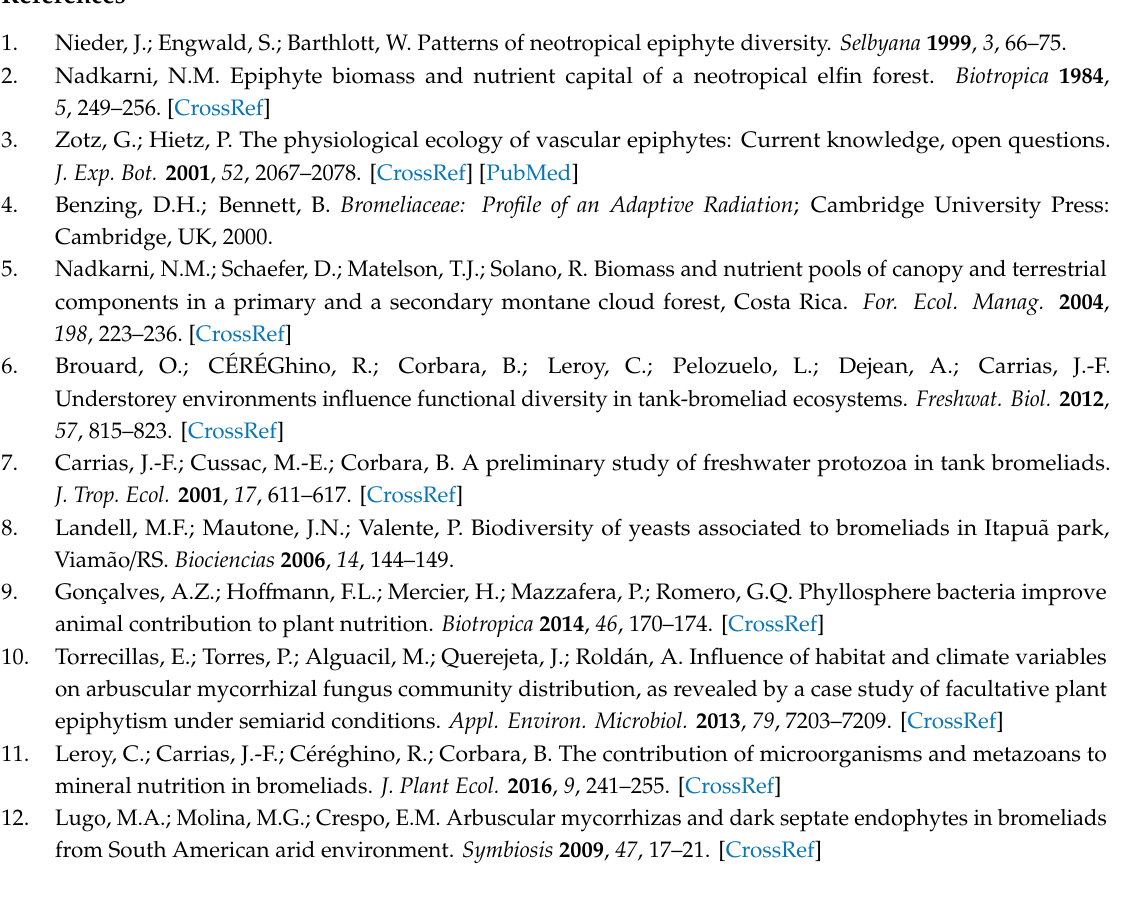
Figure S1: Correlogram of relationships among bromeliad ecophysiological traits. Figure S2: Variation in relative abundance of common fungal orders in epiphytic bromeliads. Figure S3: dbRDA ordination of fungal endophytes associated with host ecophysiological traits. Table S1: ANOVA-like tests on dbRDA models of endophyte community composition and host predictive